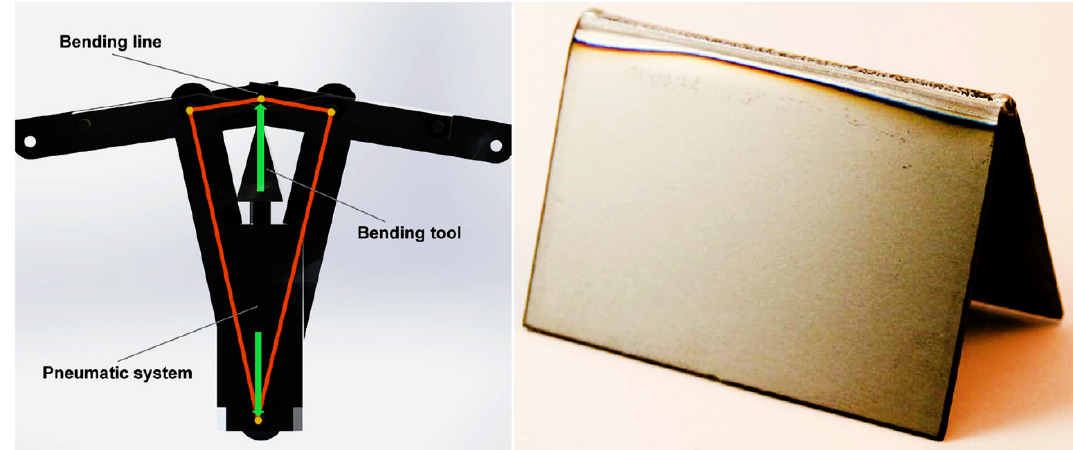
Figure 2. Bending mechanism of titanium sheet by applying an external force and the final fabricated sample [46]. (Adapted from [46], with permission from Elsevier, 2020)